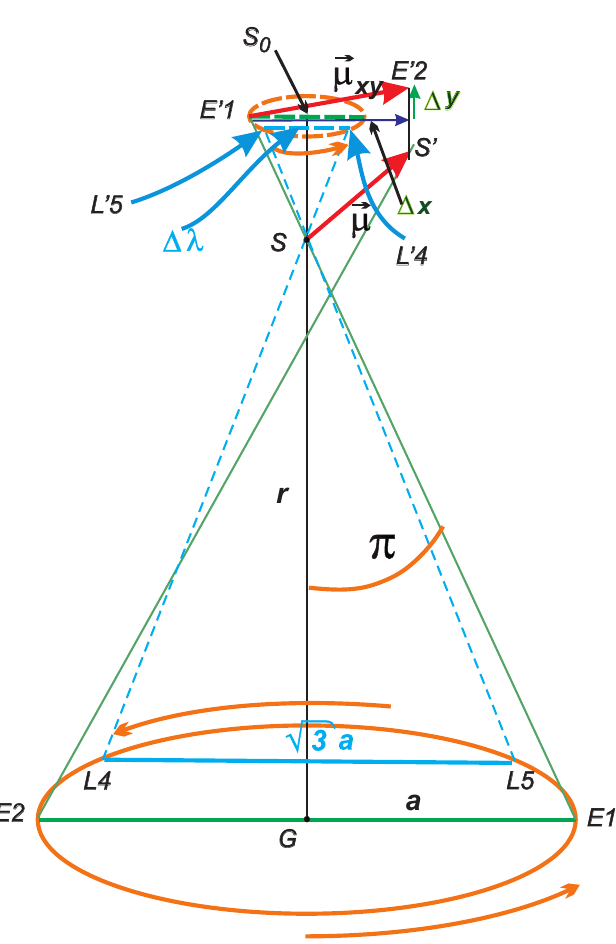
Fig. 2. Schematic presentation of the classical method for obtaining parallaxes π compared to the synchronous method for comparable baselines. π is the classical parallax of the star S . A ground-based observer can see only the components ∆ x , ∆ y of the tangential displacement vector ⃗µ xy , while an OStSO observer sees the direct parallactic p displacement ∆ λ = 3 π . Other designations are explained in the